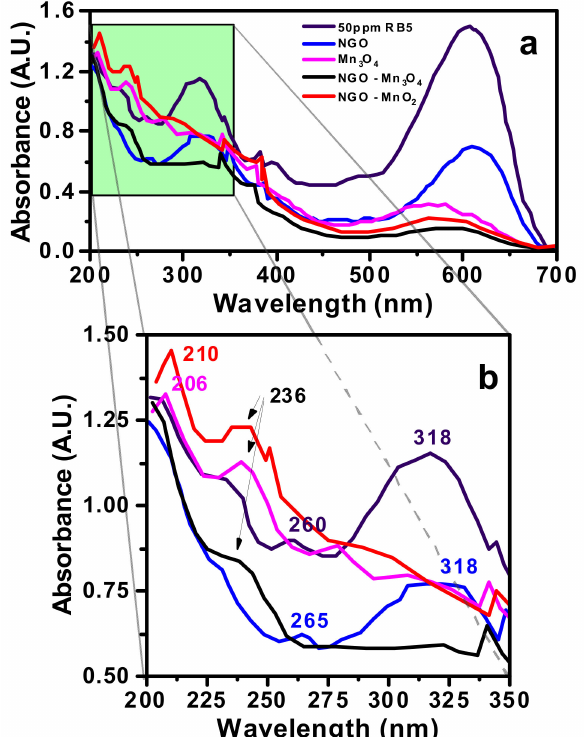
Figure 13. UV-Vis curves for RB5 ( a , b ) after degradation on NGO, MnO 2 , Mn 3 O 4 , NGO–Mn 3 O 4 and NGO–MnO 2 nanocomposites for Co = 50 mg / L (pH = 3, m = 0.01 g, V = 0.02